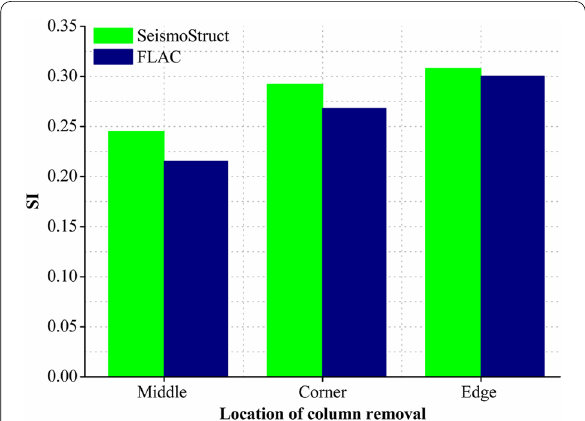
Fig. 8 The plot of the sensitivity index versus different locations of column removal in FLAC and SeismoStruct software.